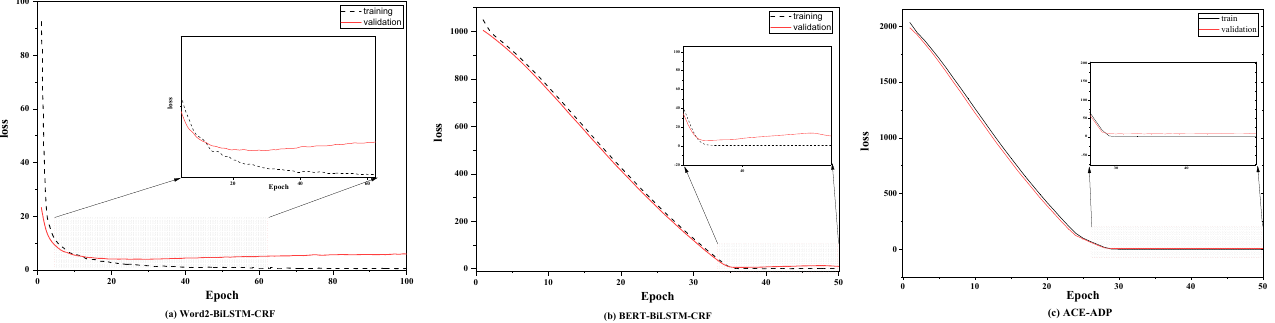
Figure 7. The training and validation losses for ( a ) Word2vec-BiLSTM-CRF, ( b ) BERT-BiLSTM-CRF, and ( c ) ACE-ADP on the AgCNER dataset. Table 7. Experimental results on extended AgCNER and